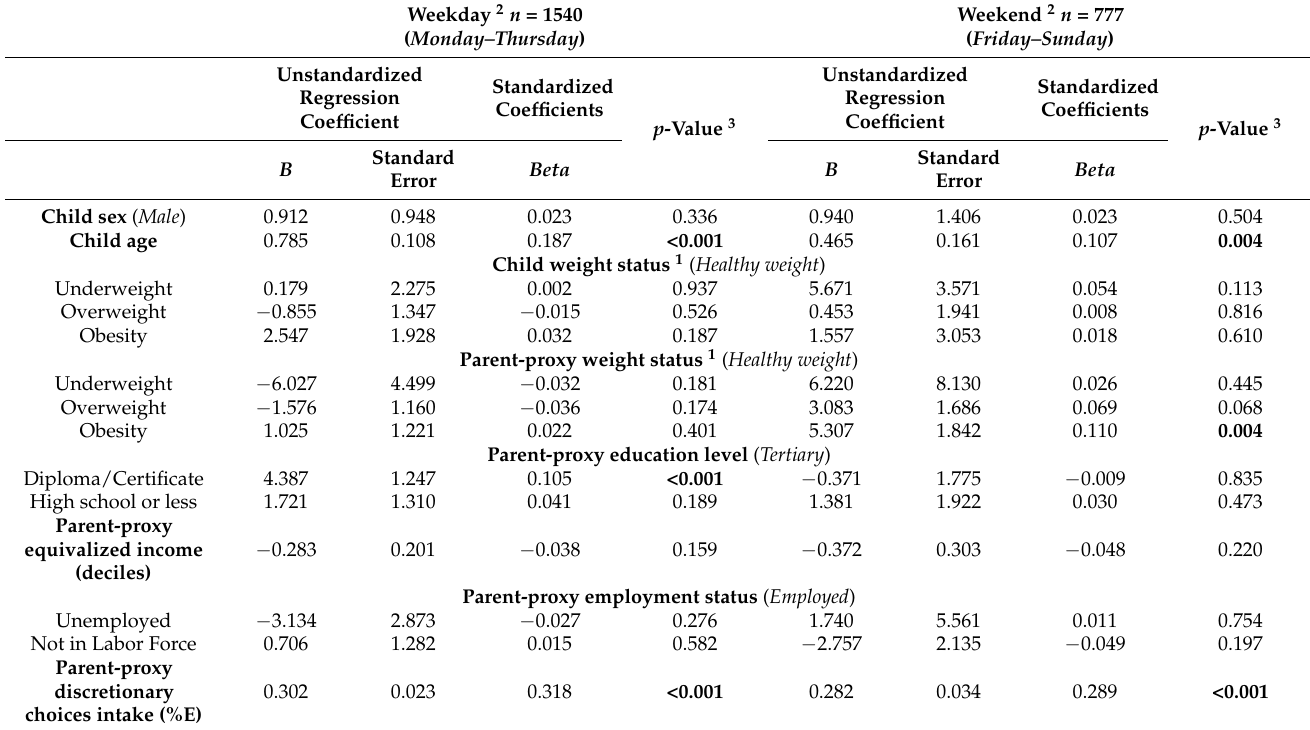
Table 5. Multivariable associations between child and parent-proxy characteristics and discretionary choices intake on weekdays (Monday–Thursday) and weekend days